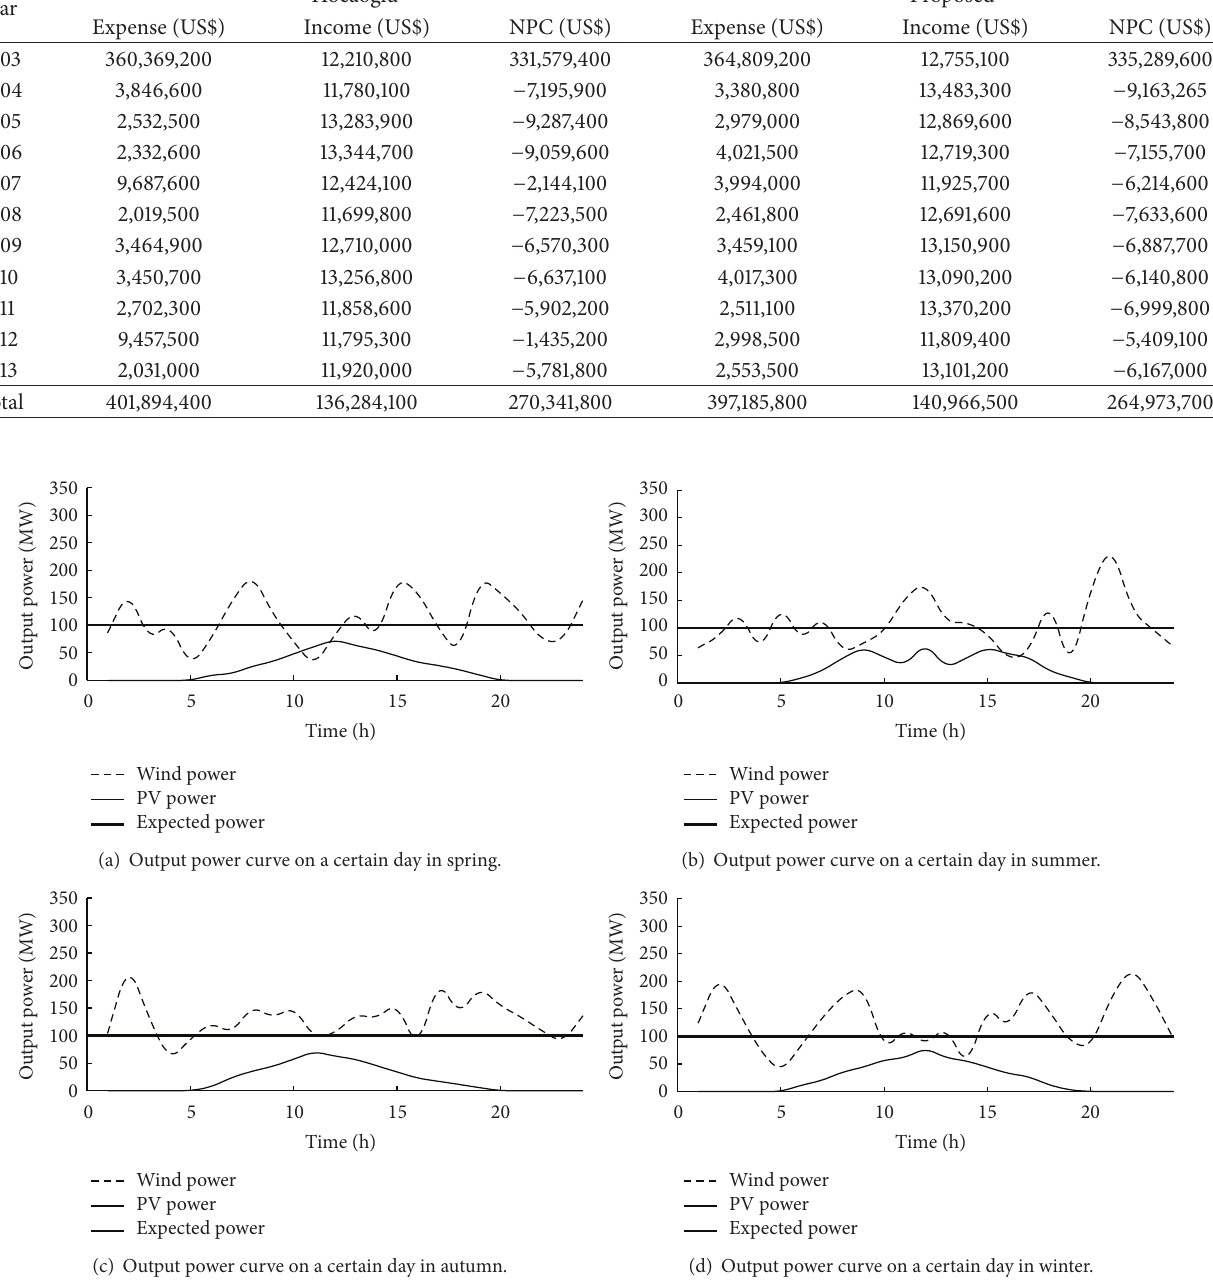
Figure 7: Output power curve on a certain day in different